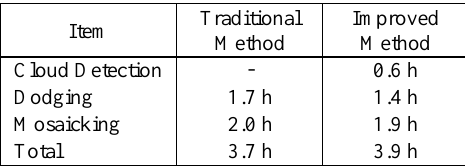
Table.3 Efficiency